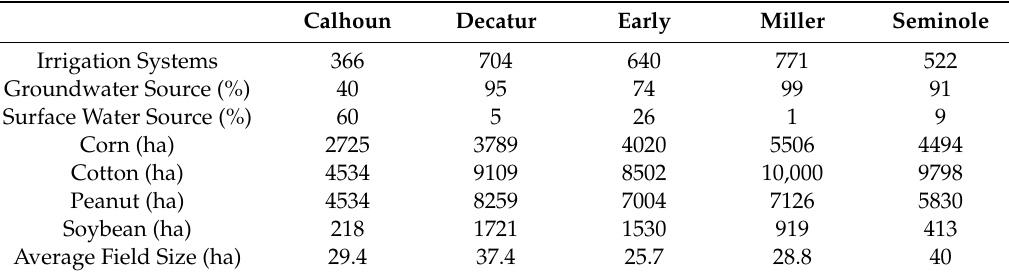
Table 1. Irrigation system parameters used.